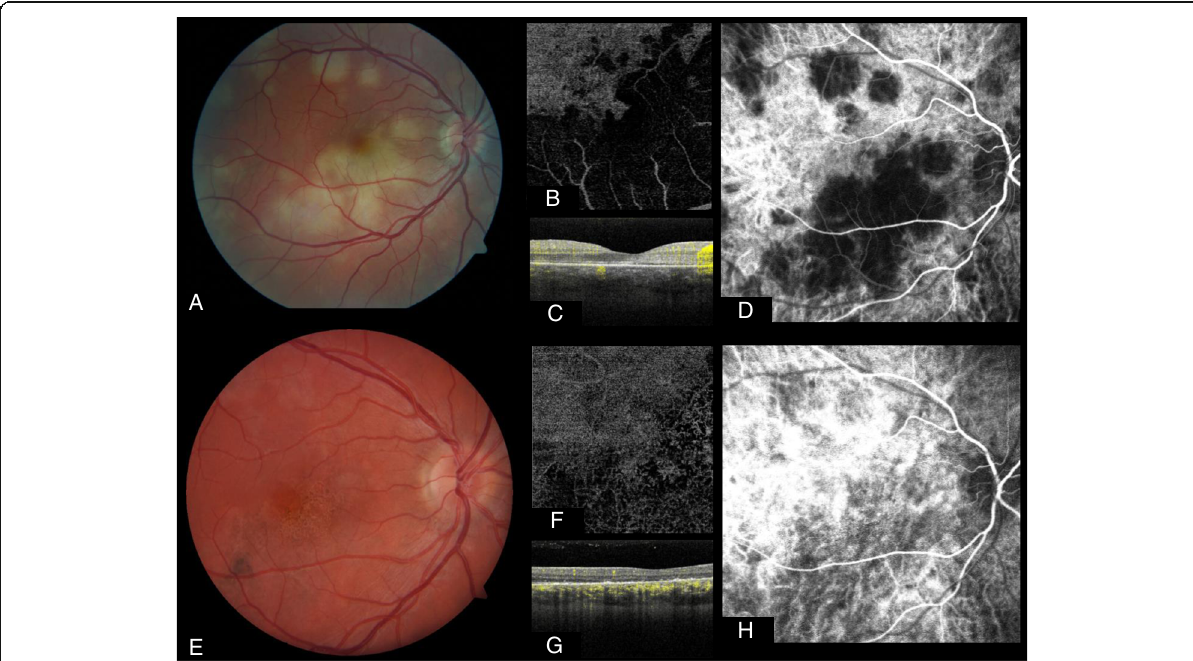
Fig. 3 Multimodal imaging analysis of the macular and peripapillary area of the right eye showing multiple lesions at different stages of acute posterior multifocal placoid pigment epitheliopathy (APMPPE). Images a , b , c and d were taken 3 days after onset of symptoms. a Color image of the fundus showing fresh lesions. b En face reconstruction of the choriocapillaris flow by optical coherence tomography angiography (OCTA) demonstrating an area of lacking signal. c Structural OCT with superimposed flow signal revealing areas with decreased flow signal. d Early phase indocyanine green angiography (IA) with a hypocyanescent area corresponding to clinically visible early lesions. Images e , f , g , and h were taken 6months after the onset of symptoms. e Color image of the fundus showing old macular lesions. f , g En face reconstruction of the choriocapillaris flow by OCTA demonstrating an increased area of low signal compared to b and c , respectively. g Structural OCT with superimposed flow signal revealing an increase of low signal compared to c . h Early-phase IA showing almost no sign of the hypocyanescent area seen in